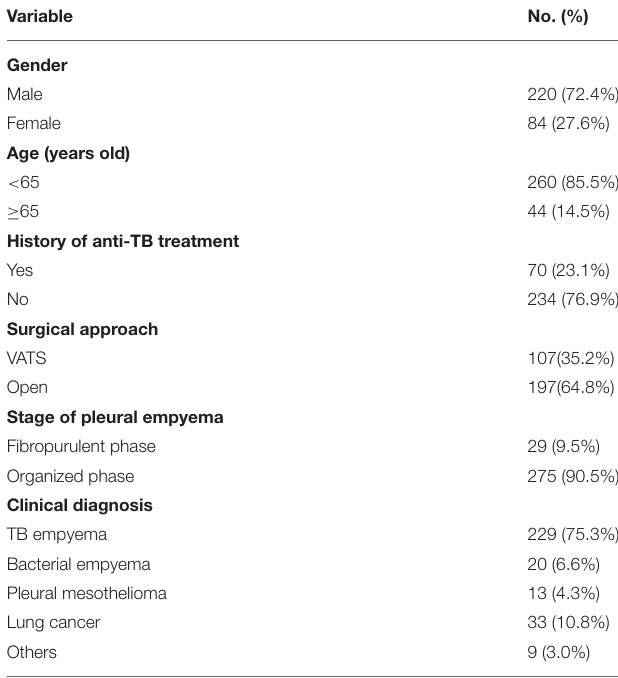
TABLE 1 | Clinical characteristics of the patients ( N = 304).